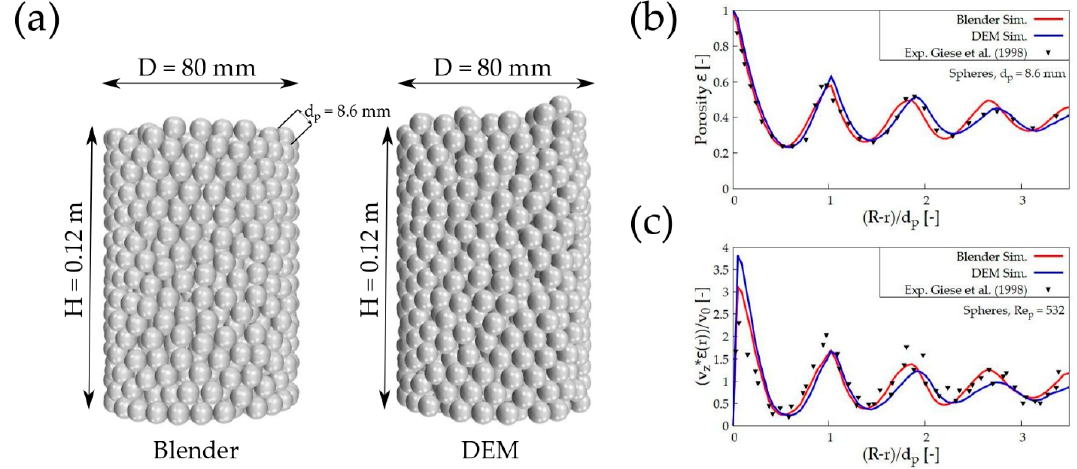
Figure 5. ( a ) Comparison between synthetic generated packing of spheres, ( b ) radial porosity profiles, and ( c ) velocity profiles. Experiments from Giese et al. [30].